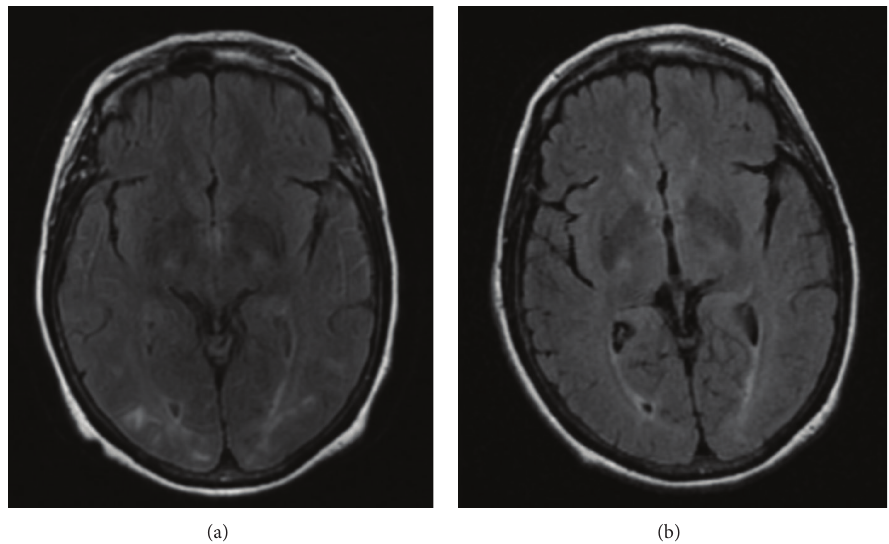
Figure 1: FLAIR MRI. (a) Subcortical lesions mainly located in posterior regions. (b) A month later an improvement of white matter lesions was